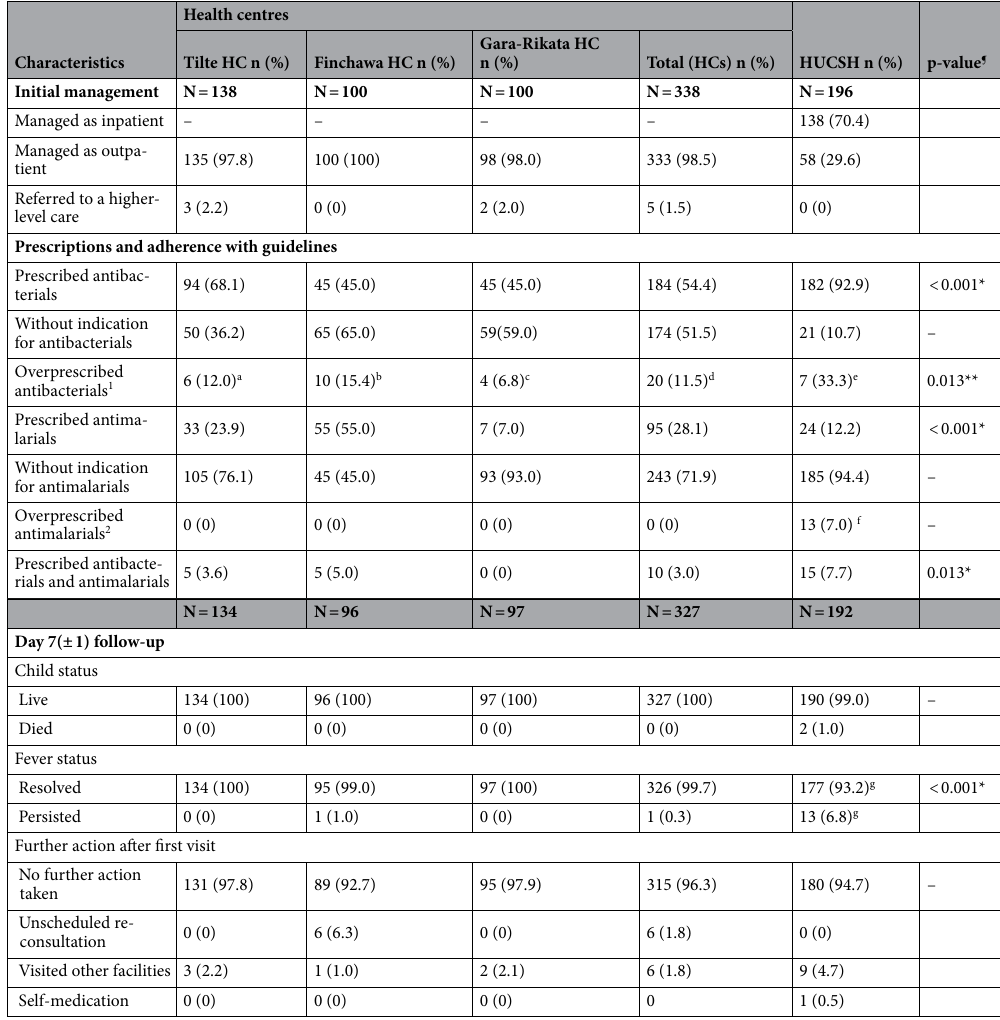
Table 4. Clinical management and outcomes of febrile children attending HUCSH and health centres in Hawassa City, 2019. HC health centre, HUCSH Hawassa University Comprehensive Specialized Hospital. ¶ Comparison of proportions between all health centres and HUCSH. 1 Among children without indication for antibacterial treatment according to guidelines. 2 Among children without indication for antimalarial treatment (without laboratory confirmation of malaria). a (N = 50), b (N = 65), c (N = 59), d (N = 174), e (N = 21), f (N = 185),